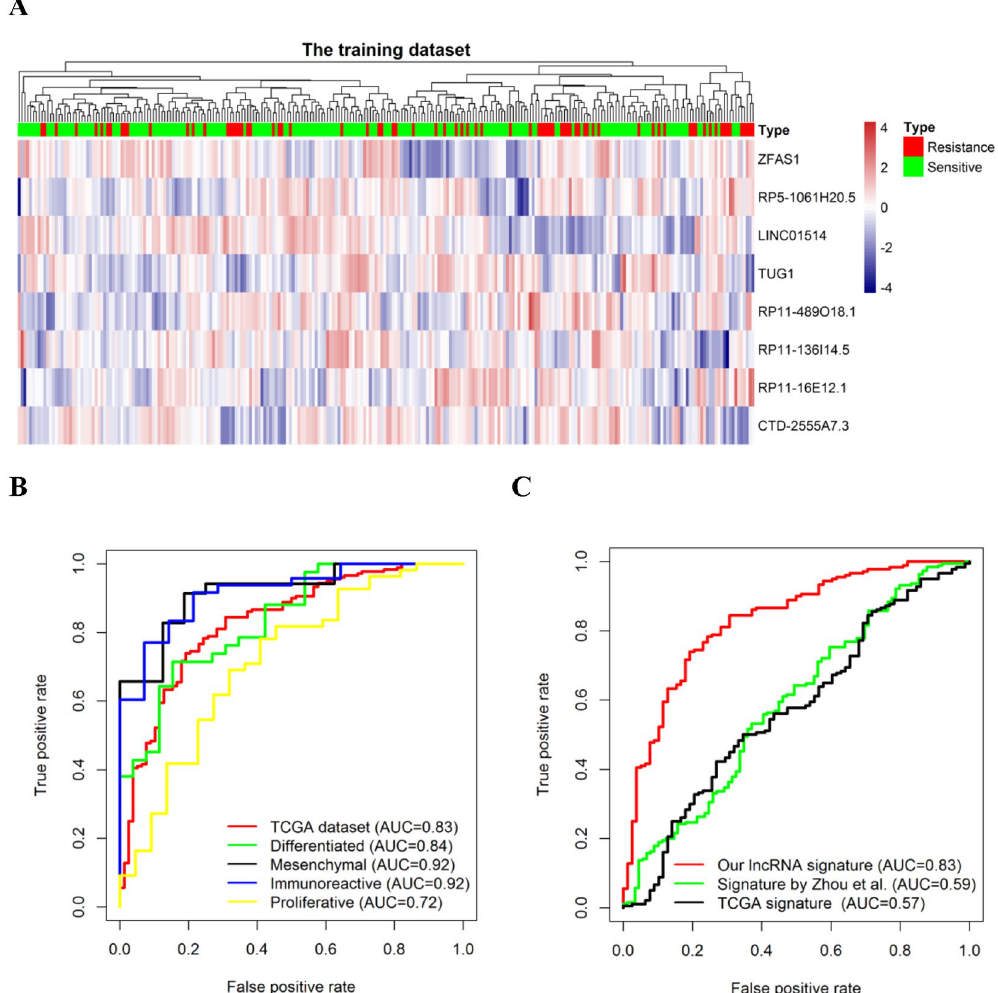
Figure 1. Unsupervised clustering heatmap and ROC curves for the eight- lncRNA signature. Heatmap based on eight lncRNAs (rows) of HGS-OvCa patients (columns) in the TCGA datasets (n = 258). Red and blue indicate high and low expression levels, respectively ( A ). ROC curves represent the accuracy of the eight- lncRNA signature in the TCGA dataset and different subtypes ( B ), and ROC curves represent the accuracy of our defined signature, the lncRNA signature developed by Zhou et al. , and the TCGA mRNA prognostic signature ( C ). True positive rate represents sensitivity, whereas false positive rate is one minus the